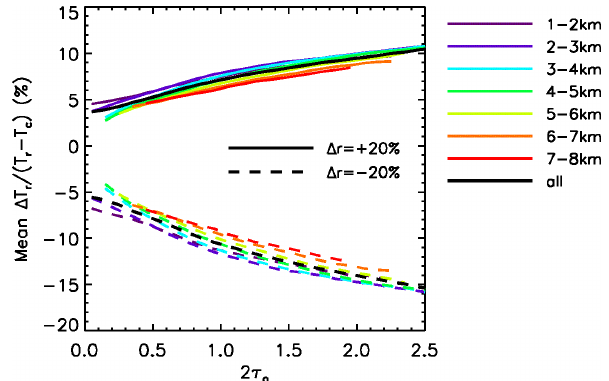
Figure 4. Relative sensitivity (in percentage) of the difference T r – T c to a variation of (cid:49)r =+ 20% (solid lines) and (cid:49)r =− 20% (dashed lines) of the assumed τ vis / τ a ratio r = 2. Colored lines are for sev- eral ranges in cloud geometric thickness (cid:49)z .The black lines are for all samples. Same data set as in Fig.